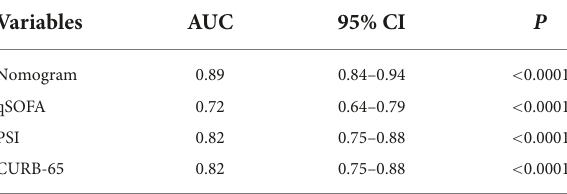
TABLE 8 The AUC of nomogram, PSI, CURB-65, and qSOFA for mortality in external validation